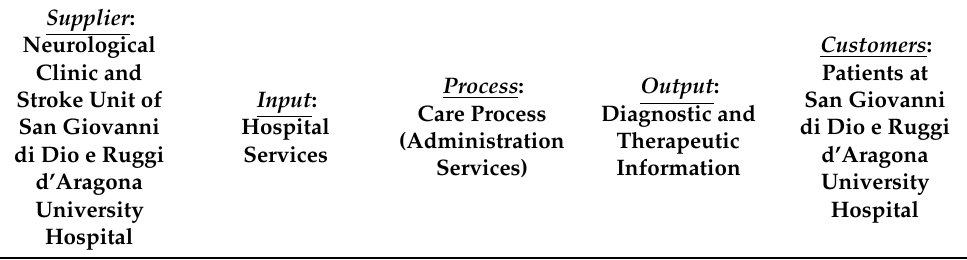
Table 2. SIPOC for the Neurological Clinic and Stroke Unit.